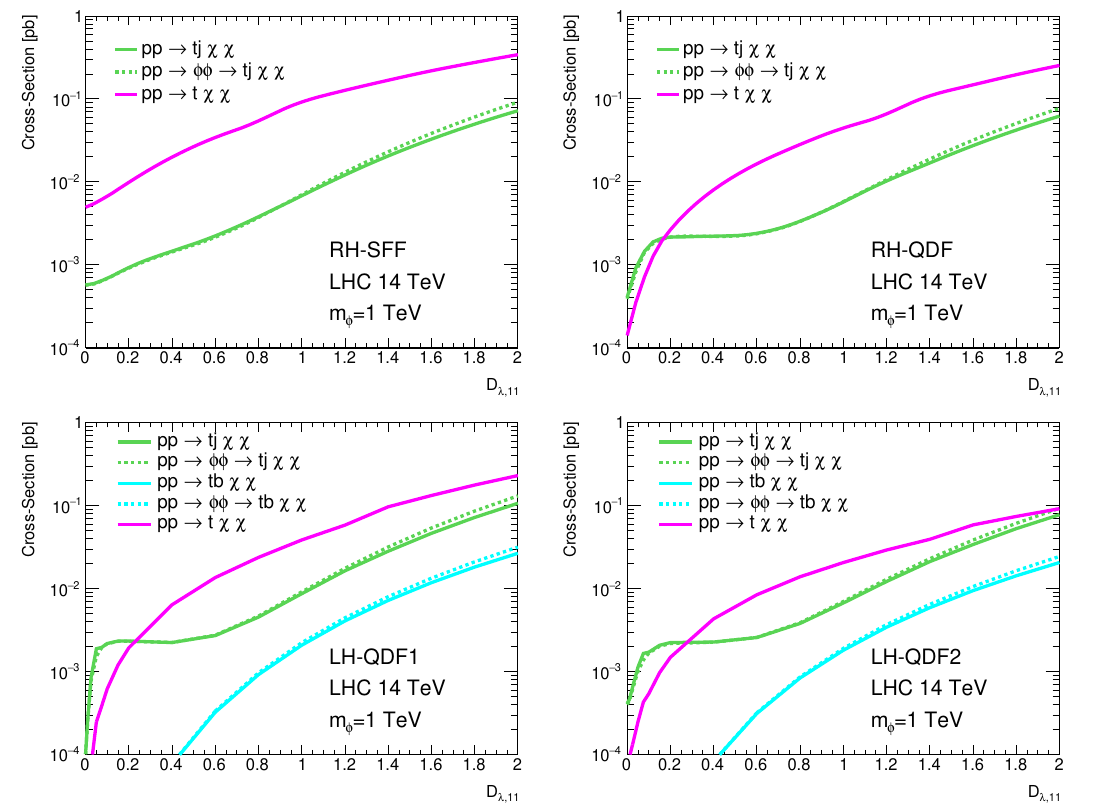
Figure 10 . Production cross-section for the single top signatures in 14 TeV proton-proton collisions for the four benchmarks, as a function of D . For the tj and tb final states both the value for the λ, 11 full cross-section and the one through resonant production of mediator pairs is shown. The value of m is fixed at 1 Φ